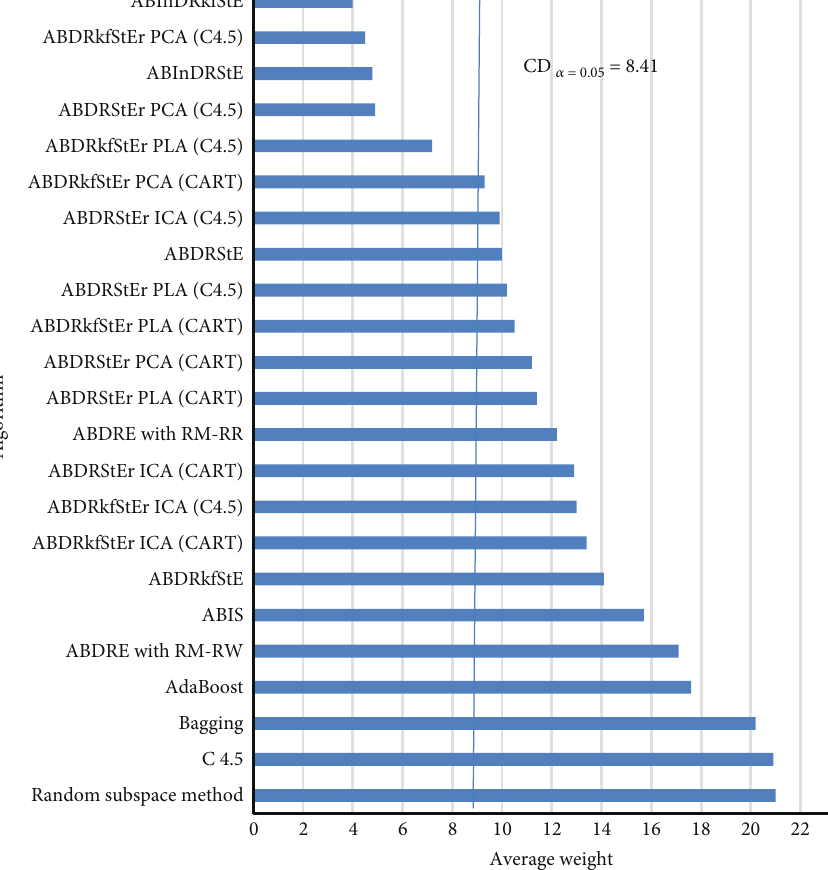
Figure 3: The average Friedman test weights and Bonferroni-Dunn ’ s graphics corresponding to the obtained